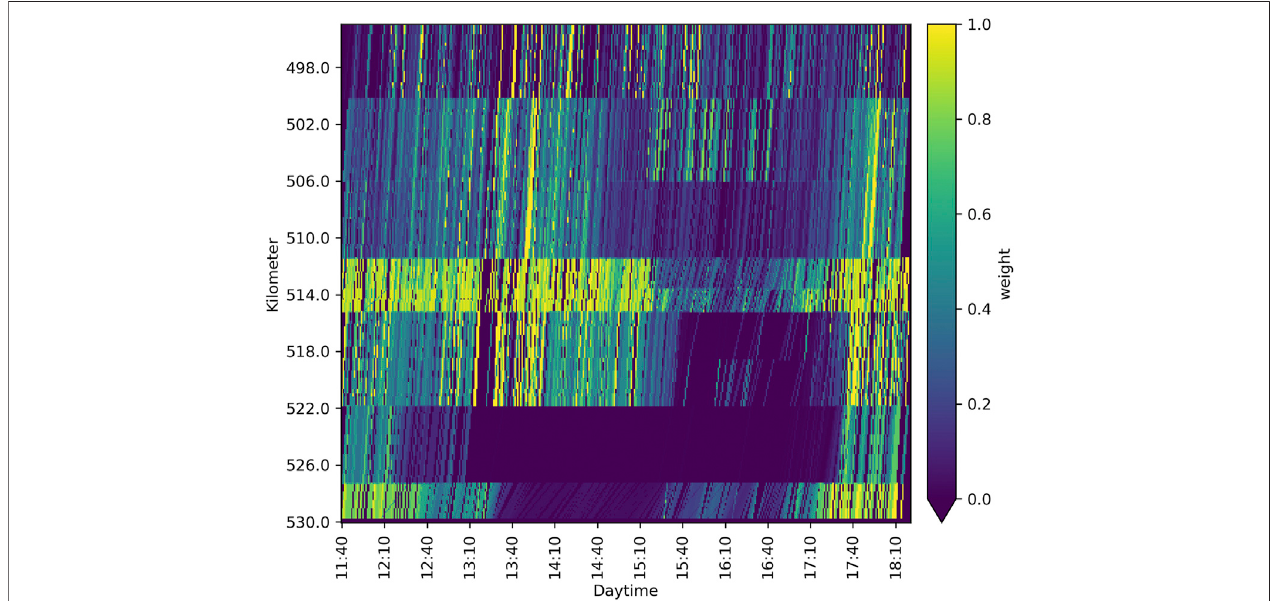
FIGURE 7 | Resulting weight applying the speed-adaptive conversion of travel time samples.